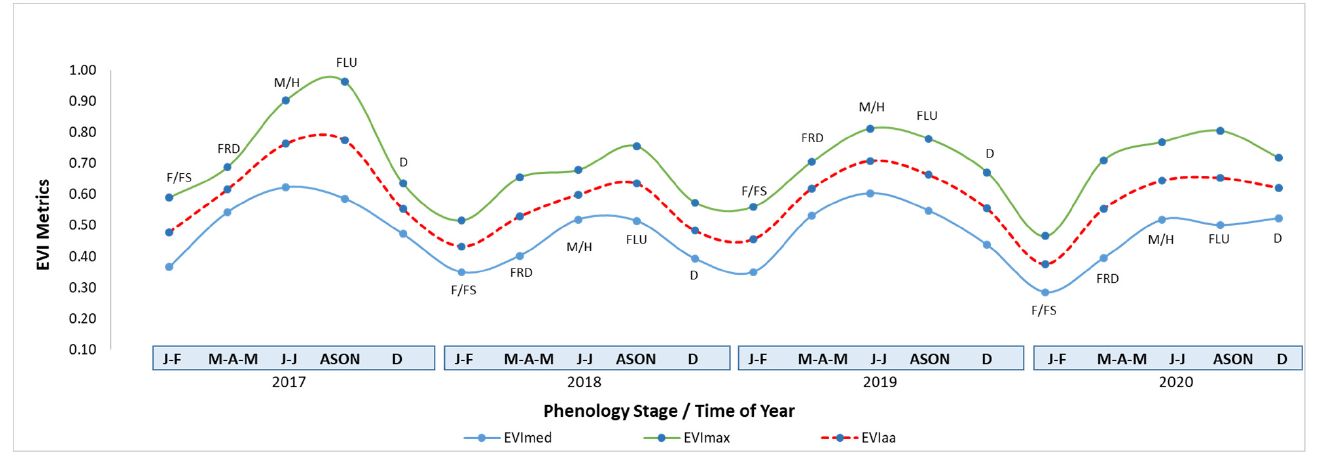
Figure 7. Temporal profile of mango in relation to the phenology cycle across the 4-year time series of median and maximum EVI metrics (EVI med , EVI max ) together with their overall yearly average (EVI aa ) from the Akorle Farm 1.